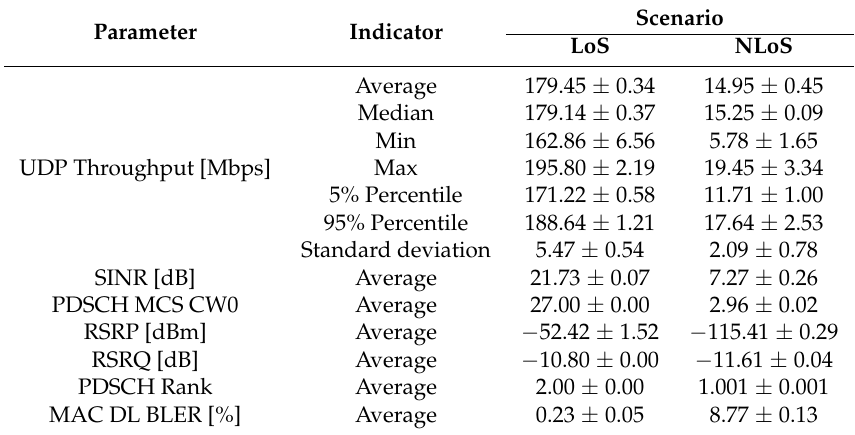
Table 4. Experiment 1: Statistical results of TC_THR_UDP test case in SC_LoS_PS and SC_NLoS_PS scenarios (Acronyms, as per Table 2; PDSCH MCS CW0 stands for Physical Downlink Shared Channel MCS for Codeword 0).